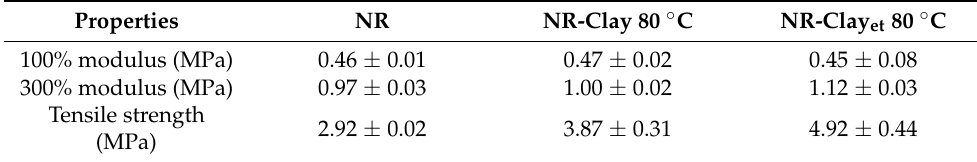
Table 3. Mechanical properties of NR/Clay composites without curing agent.